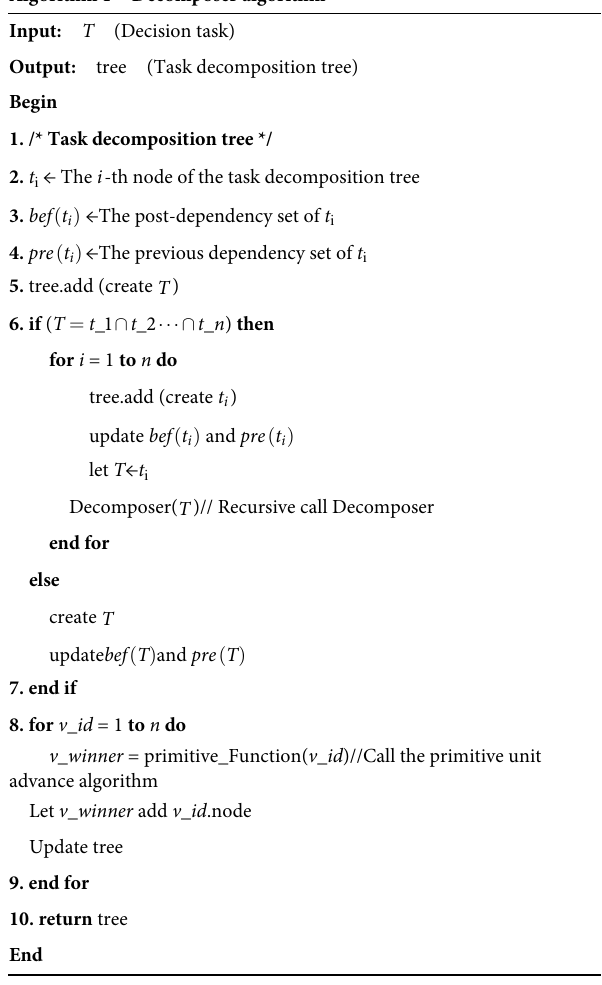
Algorithm 1 Decomposer algorithm Algorithm 2 Integrator